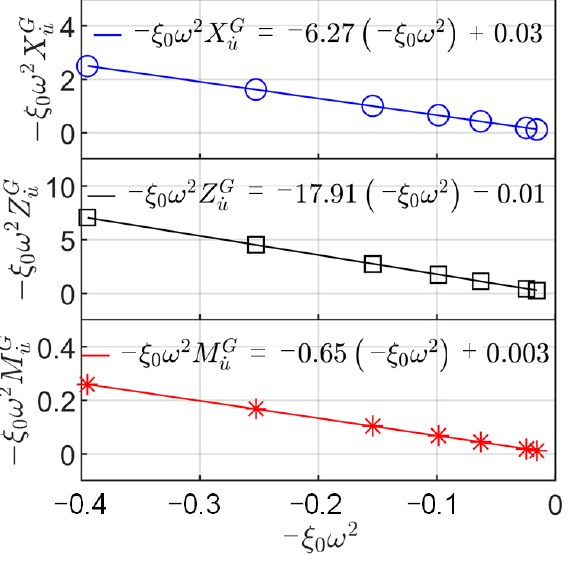
Figure 10. Simulation and fitting results ( θ = 15 G Combining all fitting results of pure surge simulation data, coefficients under different pitching angles of the hydrofoils are shown in Figure 11.